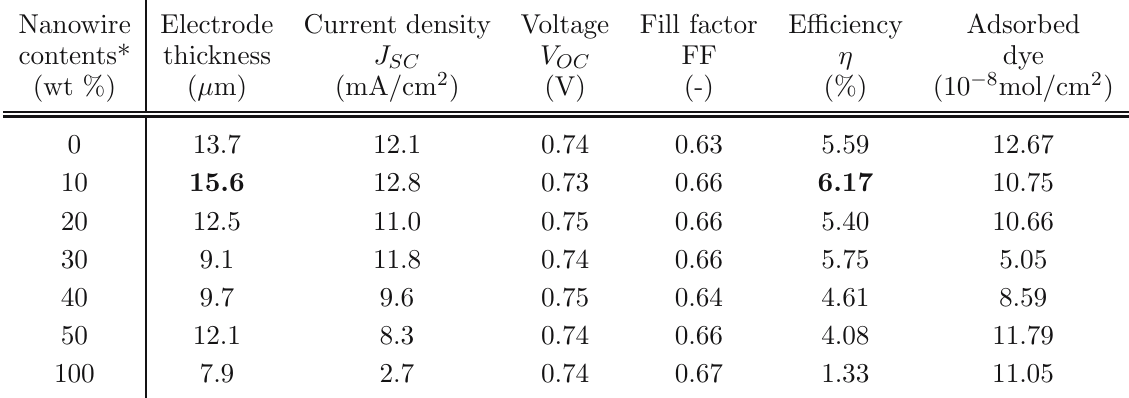
Table 1 Photovoltaic performances for various TiO 2 (B) nanowires compositions.